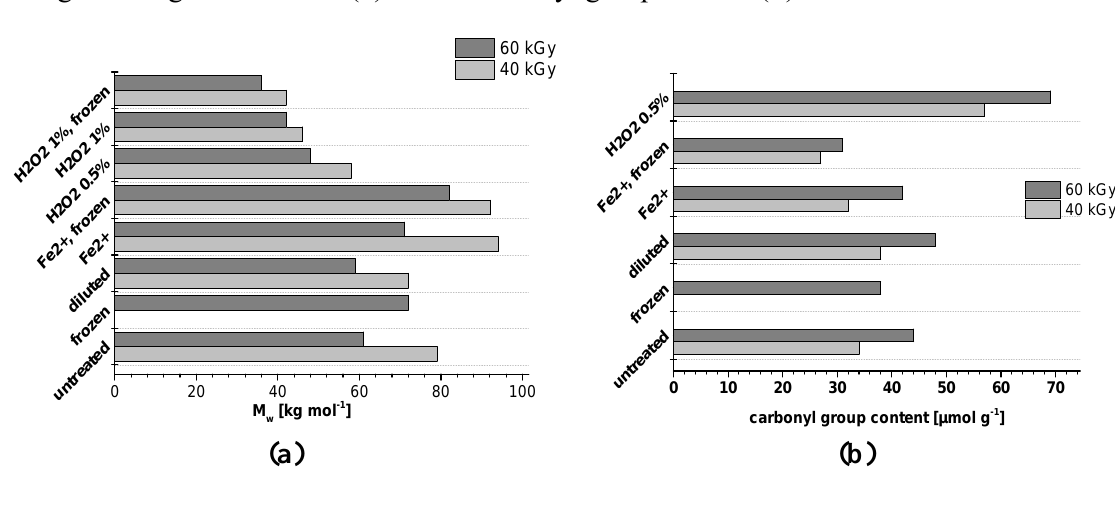
Figure 1. Modification of irradiation treatments and their impact on pulp with regard to weight average molar mass ( a ) and to carbonyl group content ( b